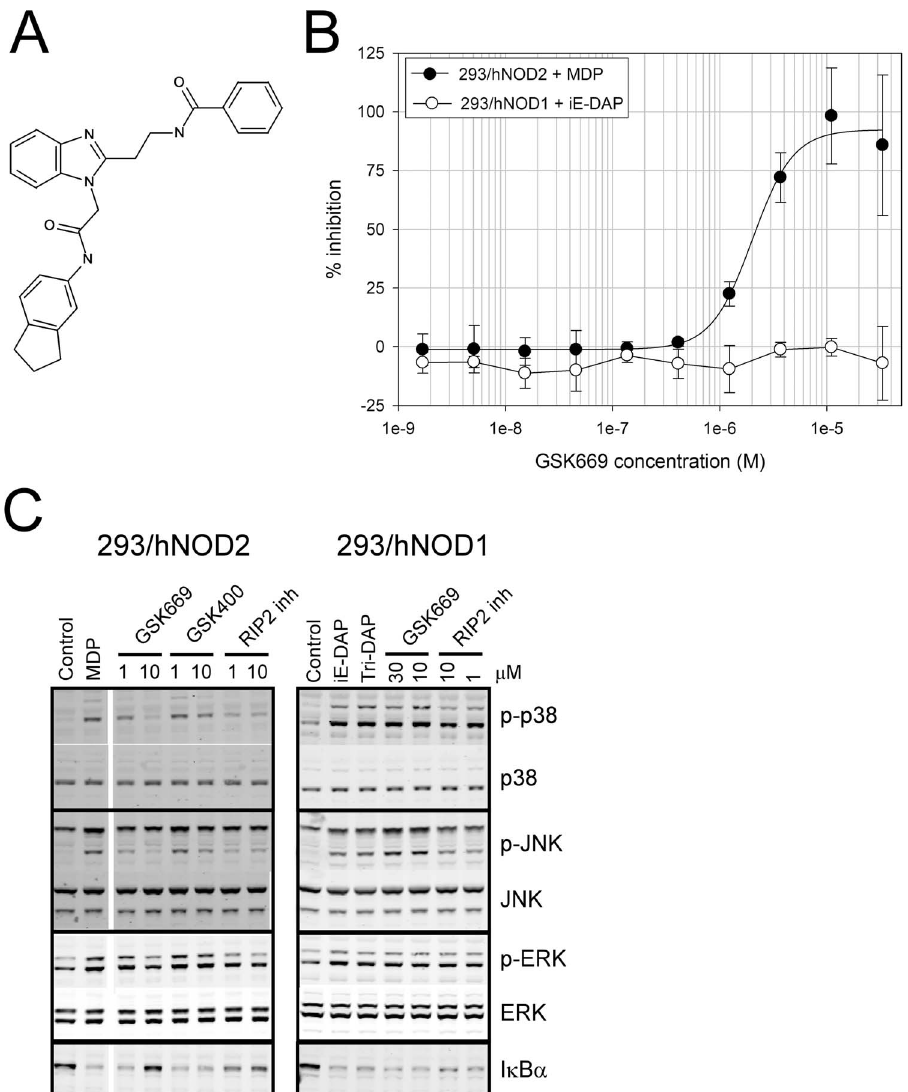
Figure 2. GSK669 inhibits NOD2 but not NOD1 mediated responses. (A) Structure of GSK669, the original hit identified from the NOD2 HTS screening cascade. (B) Concentration response curves showing GSK669 selectively inhibits MDP-stimulated IL-8. IL-8 secretion in either MDP treated 293/hNOD2 or iE-DAP treated 293/hNOD1 stable cell lines was measured in the presence of increasing concentrations of GSK669. Data are mean 6 SD from 6 independent assays. (C) Selective inhibition of NOD2-mediated MAPK phosphorylation by GSK669. Serum-starved 293/hNOD1 or NOD2 stable cells were pre-incubated with compound at the concentrations indicated and then stimulated for 1 hour with either Tri-DAP or MDP, respectively. Phospho-p38, JNK and ERK1/2 were identified in cell lysates by western blotting. A RIP2 inhibitor compound was used as a positive control. Similar results were obtained in 5 (293/hNOD2) and 2 (293/hNOD1) separate experiments.